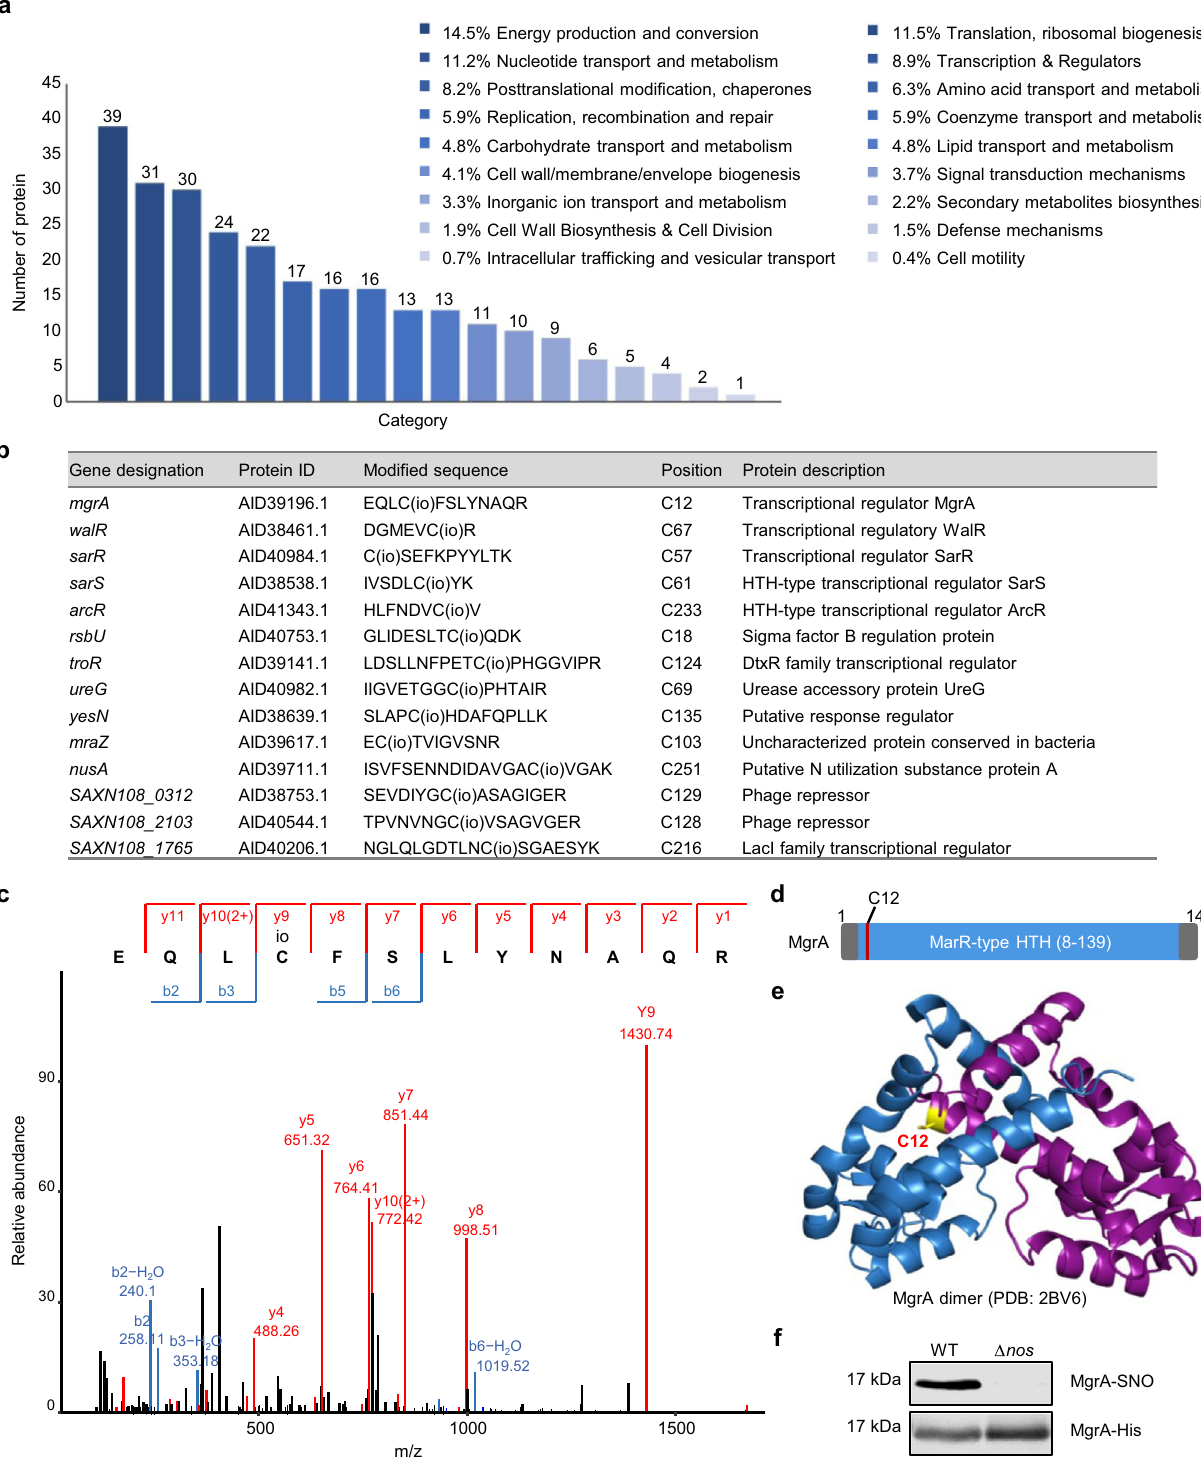
located withinthe MarR-type HTHdomain( d )and locatedatthe interfaceofMgrA dimer( e ). f S-nitrosylationofMgrApuri fi ed from the XN108WTor Δ nos strainwas detected by western blot. S-nitrosylated MgrA (MgrA-SNO) was detected with an anti-TMTantibody. TotalMgrA (MgrA-His) wasdetected with ananti-His antibody. Data are representative of n =3 biological replicates. Source dataare provided asa Source Data fi